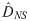
Primary school data set: Normalized temporal differences for the NetSimile distance D^NS and edit distance D^E.